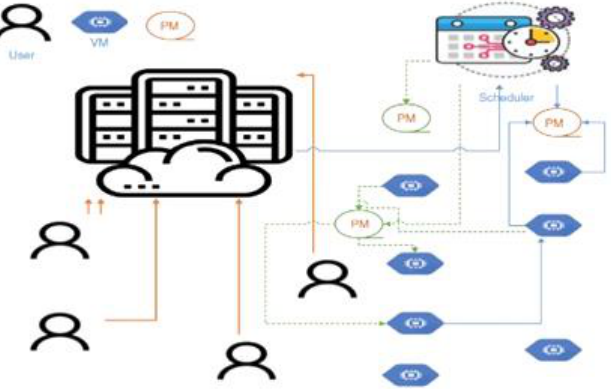
Figure 1. Virtual Machine Allocation and Migration Technique.